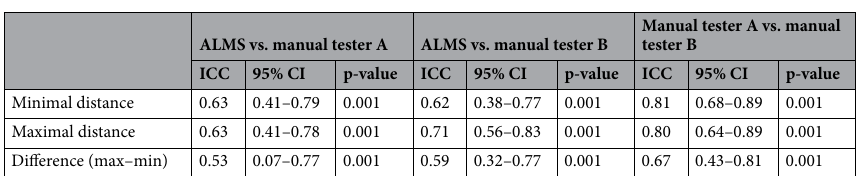
Table 3. Inter-rater reliability of ALMS and manual measurements for the talofibular joint distance between the ATFL origin and insertion points. ATFL anterior talofibular ligament, max maximal, min minimal, ALMS automated length measurement system, ICC intraclass correlation coefficient, CI confidence interval.